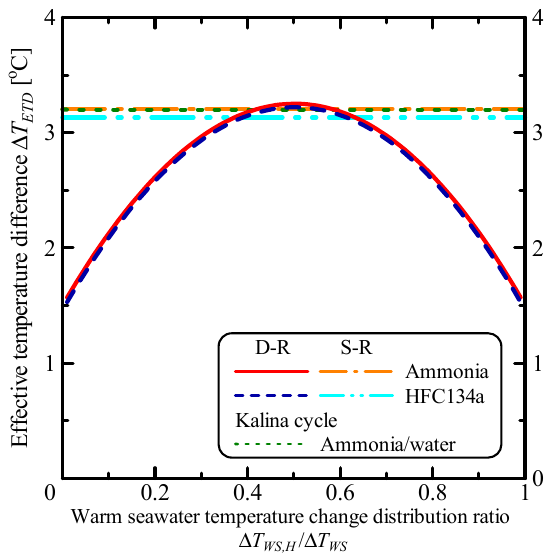
Figure 18. Relationship between the power output and the warm seawater temperature change.